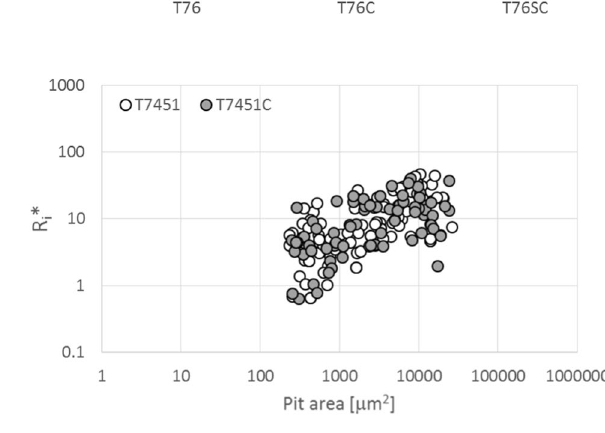
Fig. 11 Comparison among the modified roundness values in T76, T76C and T76SC tempers as a function of the